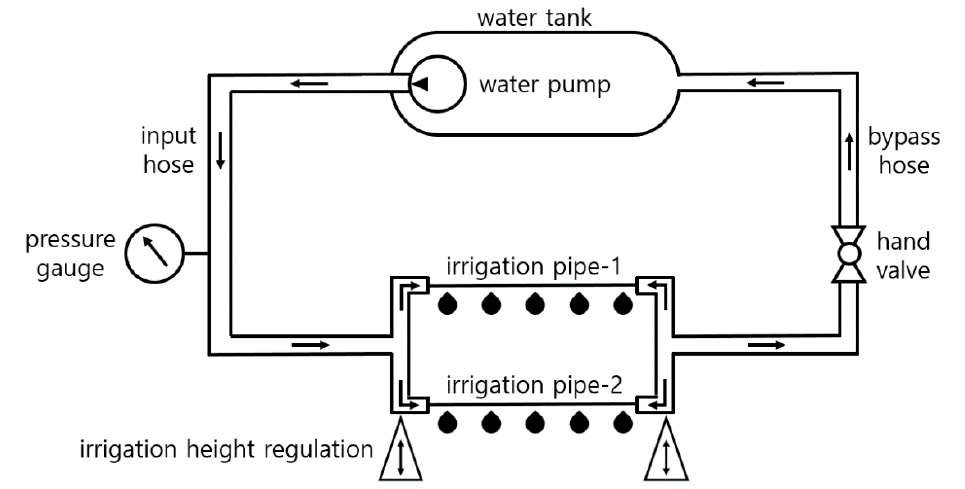
Figure 2. Schematic of the developed irrigation system.